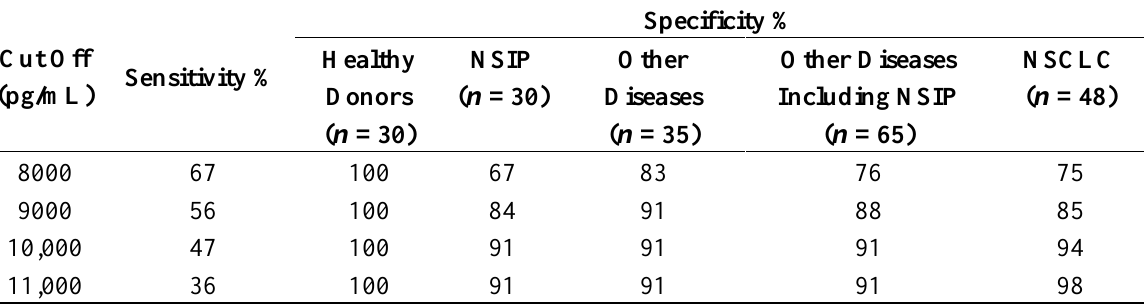
Table 5. Sensitivity and specificity values of serum MMP-7 levels in discriminating between IPF patients (45) and healthy donors or individuals with other non-malignant lung